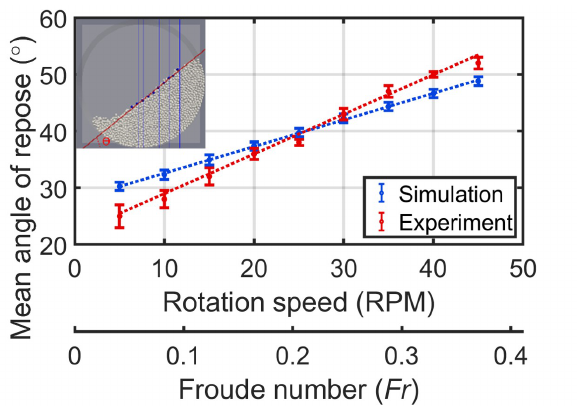
Figure 2. Experimental vs. DEM simulation of the angle of repose as a function of rotation speed and Froude number ( Fr ) for the dry case. Experimental data were obtained from Ref. [1].